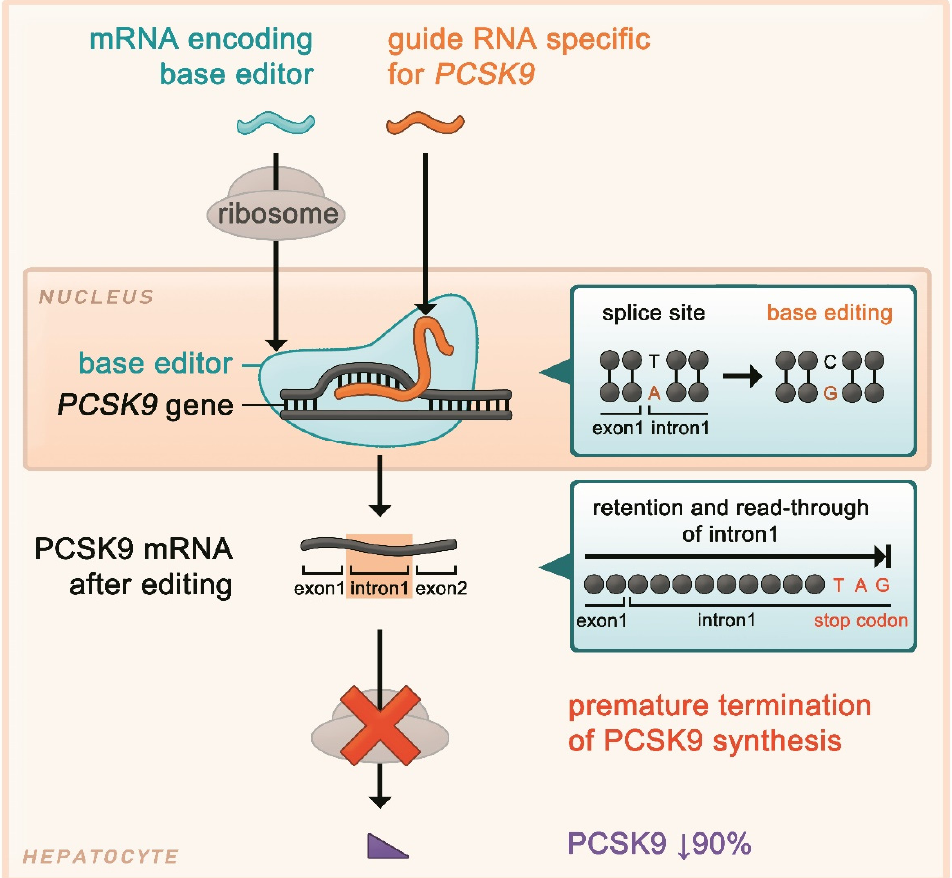
Figure 2. Genome editing of PCSK9 using a base editor that introduces a single-nucleotide change at the splice site of exon 1 and intron 1. This results in retention of intron 1 in the final mRNA, which contains an in-frame stop codon, leading to premature termination of protein synthesis.